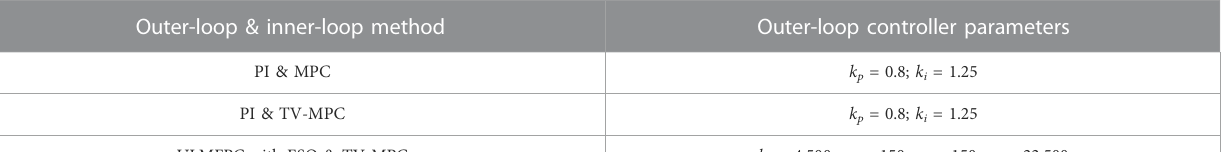
TABLE 3 Controller parameters.